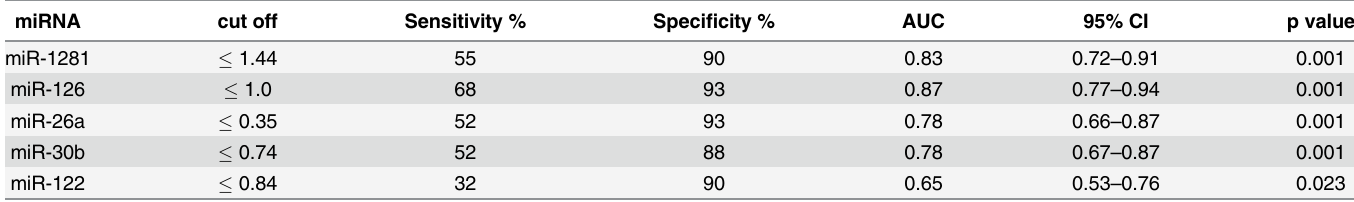
Table 1. Serum miRNA analysis. Sensitivity and specificity to distinguish between patients with primary sclerosing cholangitis (PSC) and cholangiocarci- noma (CC) for the differentially expressed miRNAs. The analysis was optimized regarding specificity. Table 1 shows sensitivity, specificity, cut off values, area under the curve (AUC) values with confidence interval (CI) and